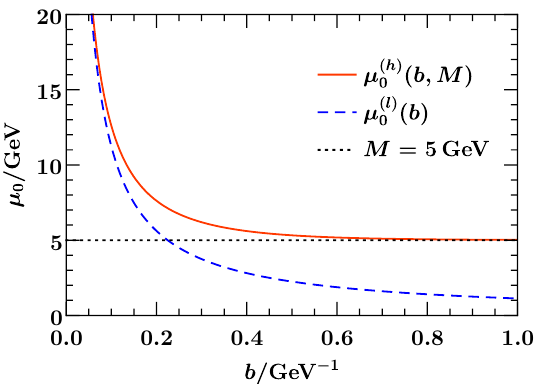
( b ) = (cid:22) 0 ( b; M = 0